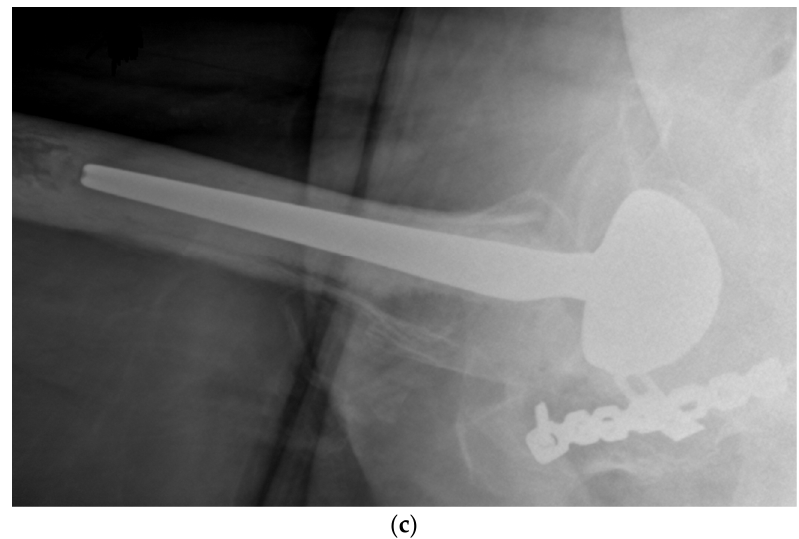
Figure 8. ( a ) Antero-posterior pelvis radiograph of an 82-year-old man with severe post-traumatic right hip osteoarthritis. The fracture and secondary degeneration modified native acetabular cavity orientation. Using a DM, LDH THA helped obtain a stable joint and may forgive potential surgical impressions. ( b ) Post-operative anteroposterior pelvis radiograph. ( c ) Lateral view of the reconstructed right hip.